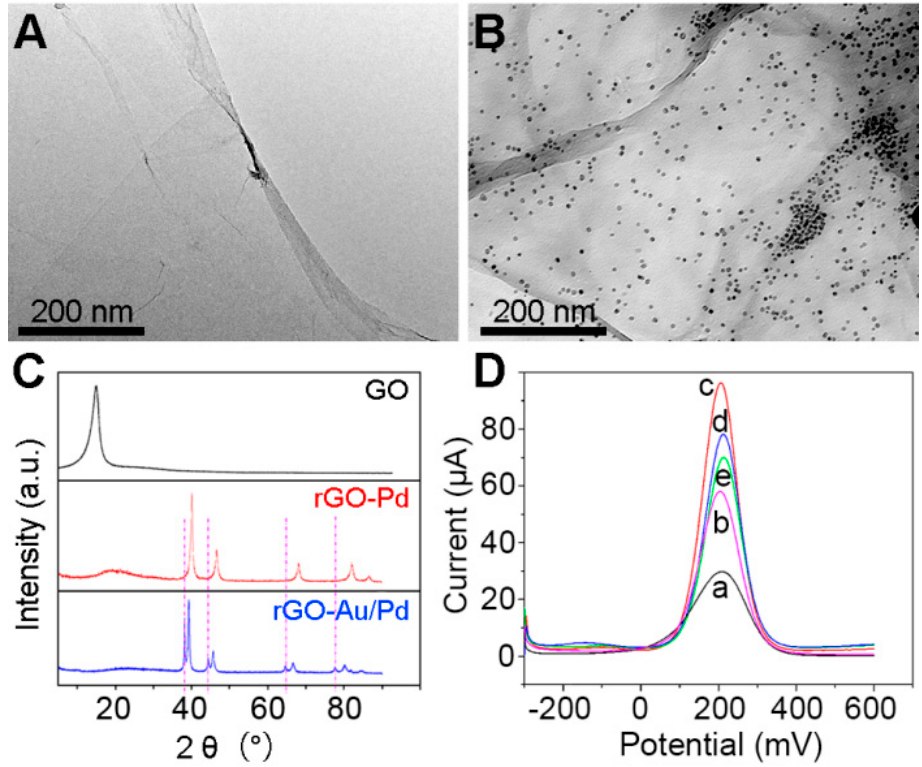
Figure 1. Characterization of the morphology, structure, and electrochemical performance of the nanocomposites. ( A , B ) Transmission electron microscopy images of GO ( A ) and rGO-Au-Pd ( B ). ( C ) X-ray diffraction profiles of GO, rGO-Pd, and rGO-Au/Pd. ( D ) Differential pulse voltammetry measurements of bare GCE, GO-Au-Pd/GCE, rGO-Au-Pd/GCE, rGO-Au-Pd-anti-CA242/GCE, and rGO-Au-Pd-anti-CA242-BSA/GCE obtained in 10 mM K 3 [Fe(CN) 6 ].